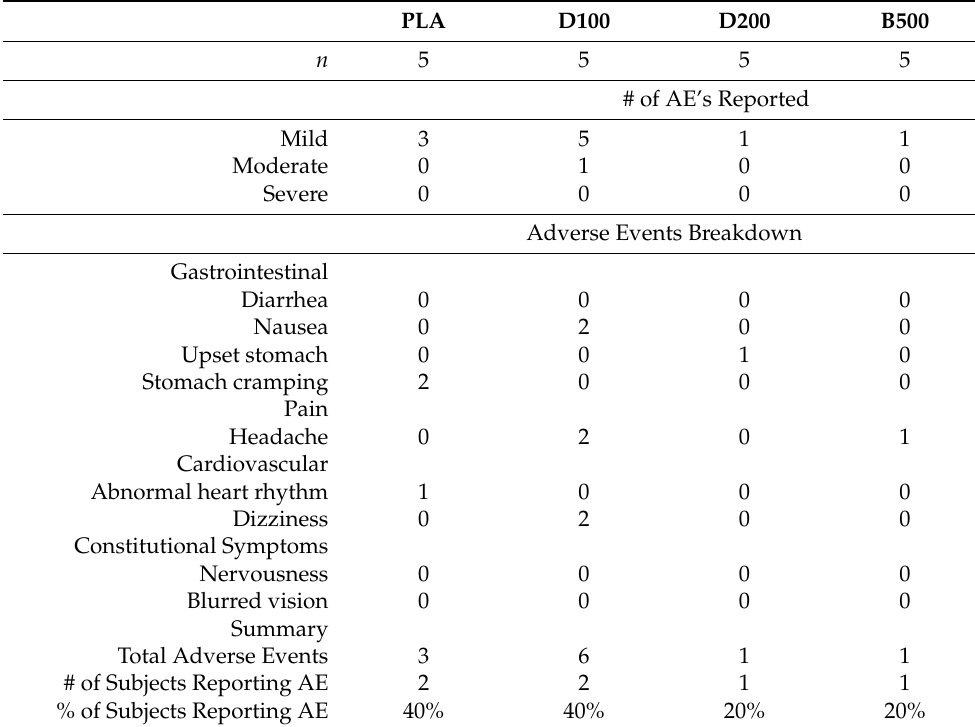
Table 3. Adverse event